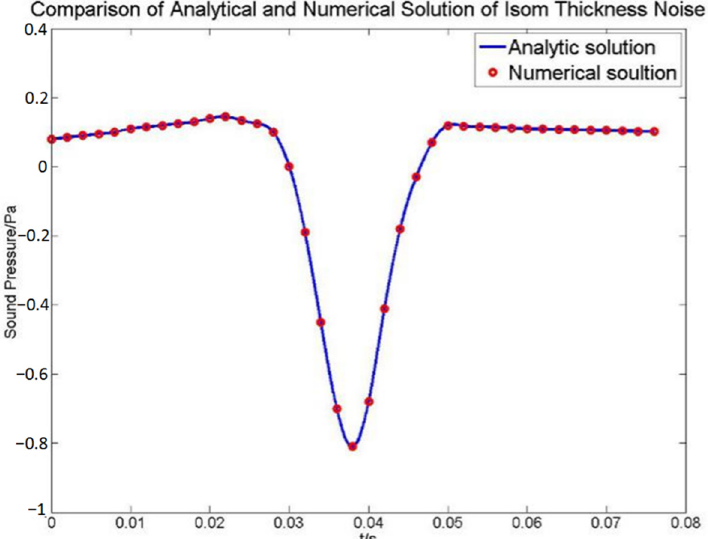
Figure 3. Comparison of sound pressure between the calculated result and experimental data of an experimental rotor. an experimental rotor.